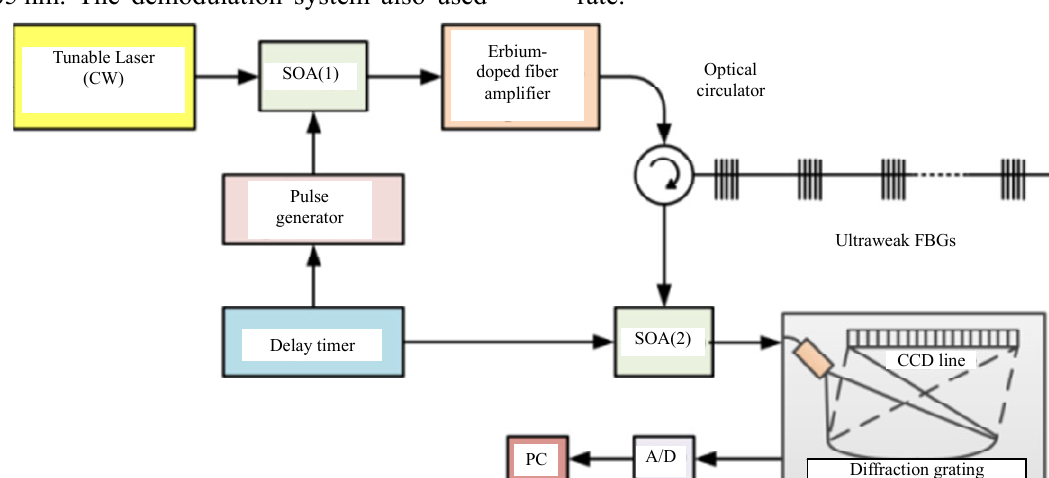
Fig. 3 Interrogation system based on two SOAs and CCD